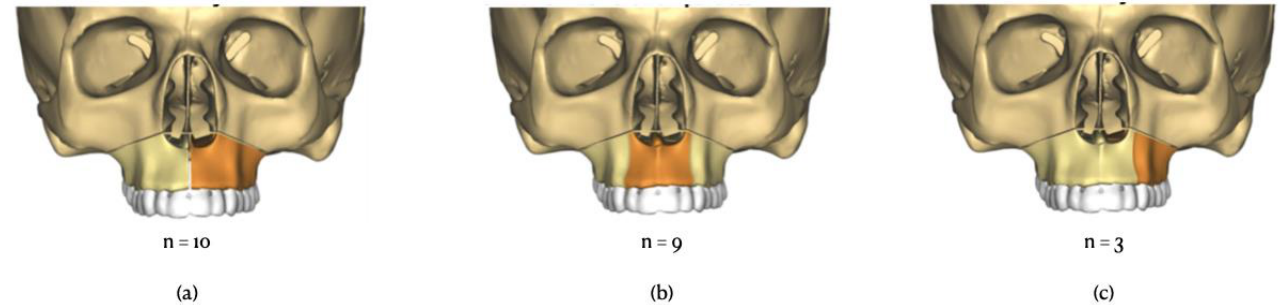
Figure 3. Types of maxillary segmentation. ( a ) Two-piece Le Fort I osteotomy with median disjunc- tion, ( b ) three-piece Le Fort I osteotomy, ( c ) two-piece Le Fort I osteotomy with asymmetric disjunc- tion (2 left, 1 right).